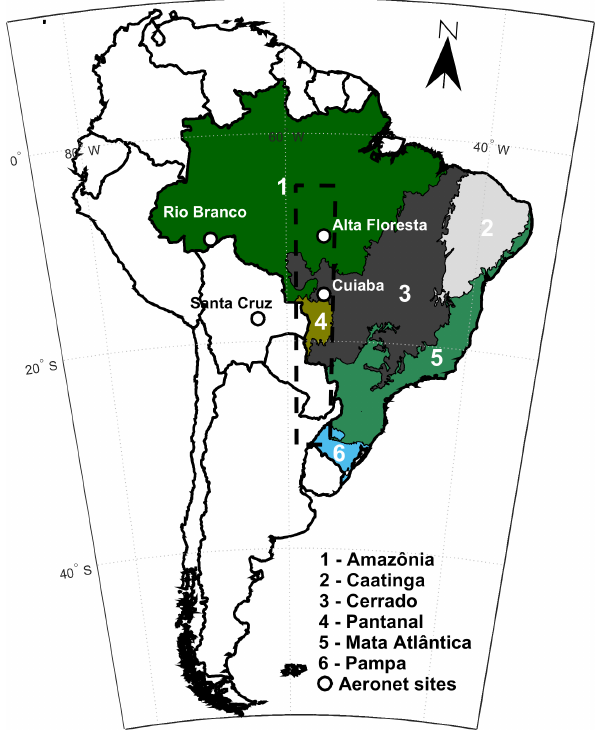
Figure 1. Spatial distribution of the Brazilian biomes of the Ama- zon tropical forest, Caatinga, Cerrado, Pantanal, Mata Atlântica, and Pampa. Locations of the AERONET (AErosol RObotic NET- work) stations considered in this study are also depicted. The area confined by the dashed red box represents a transect defined to study north–south smoke variability and transport, taking the Pantanal western and eastern borders as